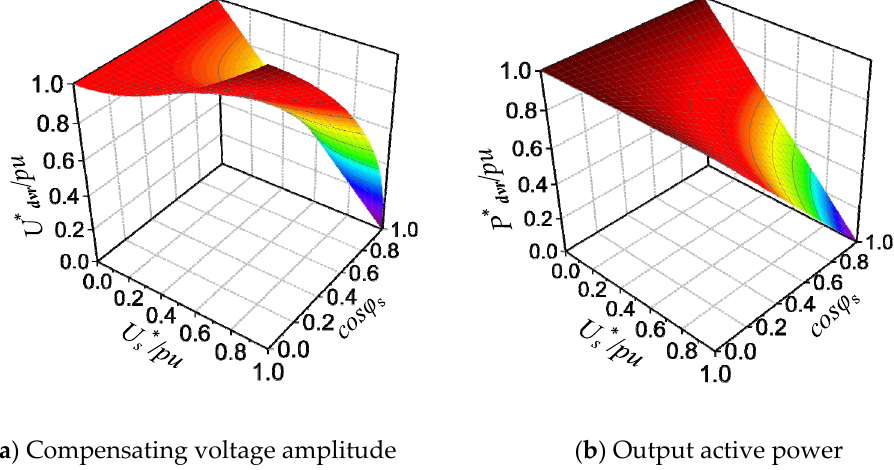
. Figure 10. Quantitative analysis of optimal energy compensation with U L s < U r cos ϕ L